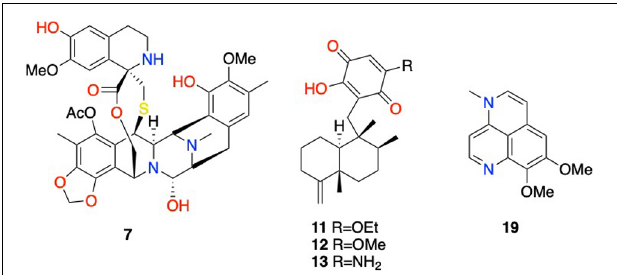
FIGURE 2 | Selected structures of compounds with reported antiviral activities displayed in Table 1 . 7 : ecteinascidin 743; 11 : isosemnonorthoquinone; 12 : ilimaquinone; 13 : smenospongine; 19 :